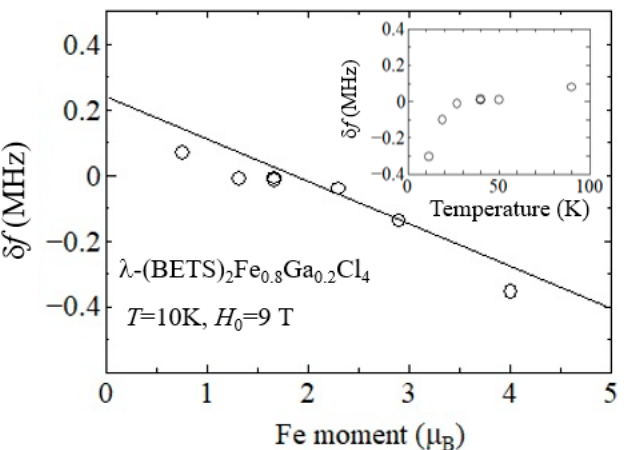
Figure 3. Temperature dependence of the NMR shift, δ f obtained at the field orientation of 30 degrees; the horizontal axis is taken as the magnitude of the Fe moment at each temperature. The solid line indicates the calculated values taking J ~5 T/ μ B . The inset shows the NMR shift as a function of temperature.